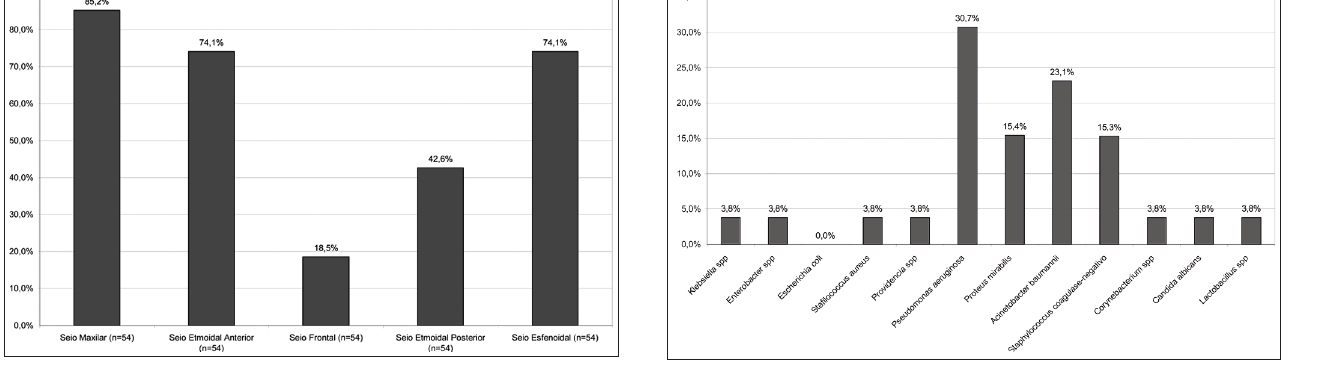
Figura 3. Distribuição dos seios paranasais com sinais radiológicos de rinossinusite. n: número de fossas nasais. Tabela 2. Distribuição da endoscopia nasal com presença de secreção purulenta no meato médio.